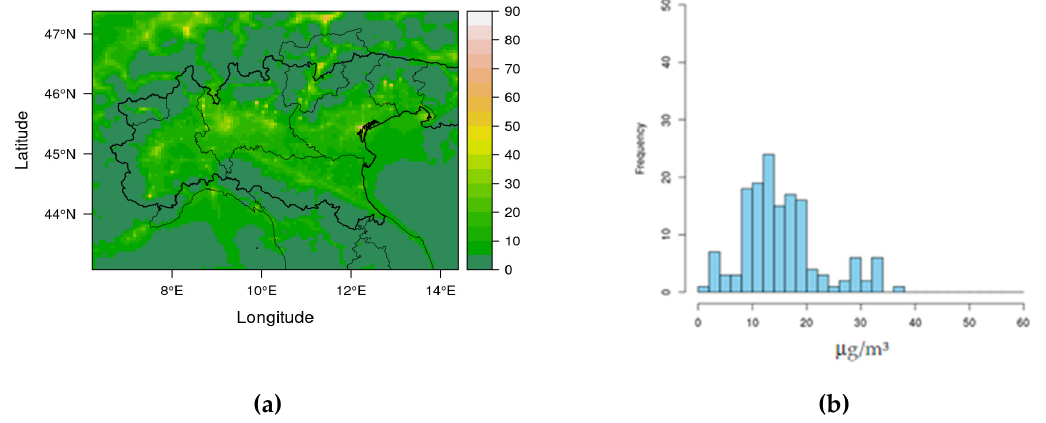
Figure 13. APS2025 NO 2 : ( a ) ground field of annual average concentration ( μ g/m 3 ); ( b ) frequency distribution of annual average concentration in background stations.